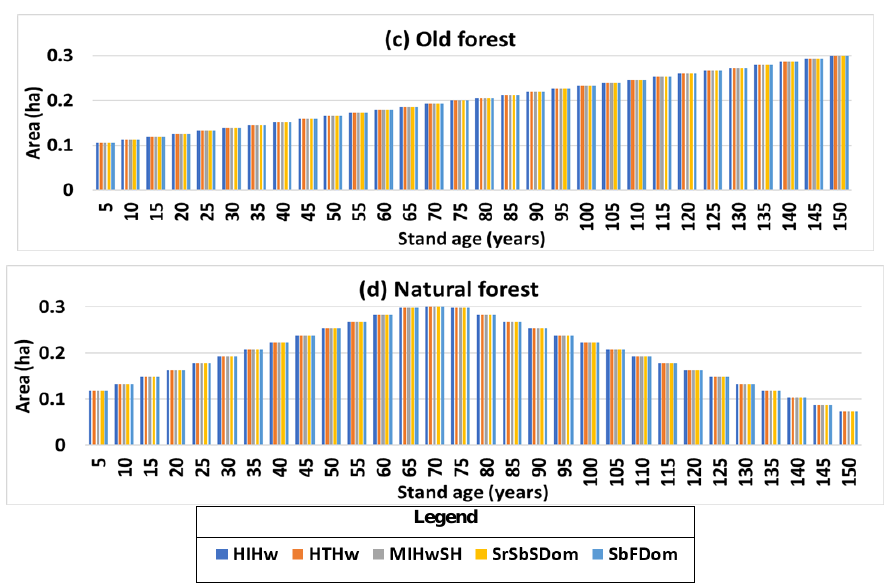
Figure 5. Hypothetical 150 ha forest with an even level of the five forest communities, under four age structures: ( a ) even-aged; ( b ) young forest; ( c ) old forest; ( d ) “natural” forest. The land base is shown in five-year age steps, but the analysis used 150 age classes (ages 1–150).